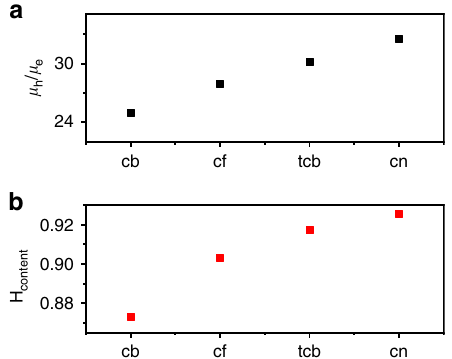
Fig. 6 Solvent dependence of mobility and I 0 – 0 / I 0 – 1 . a Solvent dependence of the holes and electrons mobility ratio ( μ e / μ h ). b Solvent dependence of the relative peak ratio between the I 0 – 1 and I 0 – 0 peak ( ∝ λ 2 ) found in A // UV – Vis. Such ratio is proportional to the H-type electron-vibration coupling. Films spun from toluene are characterized by a negligible dichroic ratio and are not considered here. Trichlorobenzene (tcb), chloroform (cf), chlorobenzene (cb), chloronaphthalene